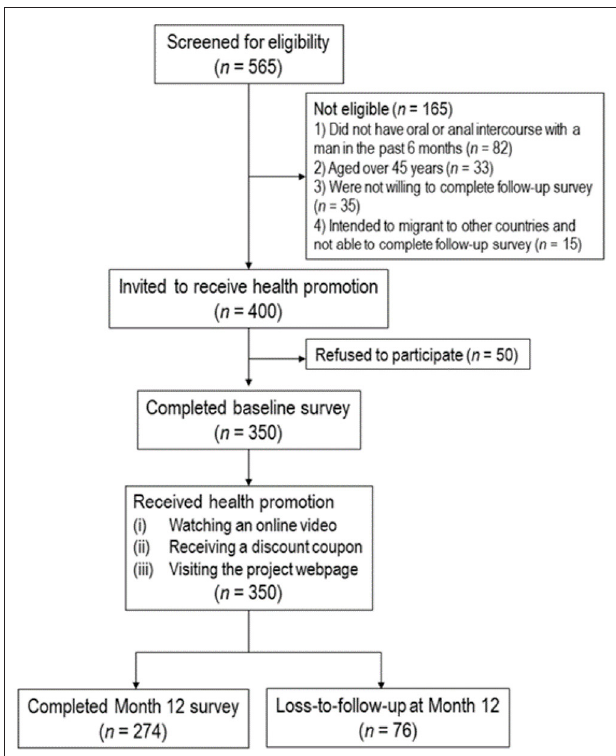
FIGURE 1 | Flowchart diagram of the